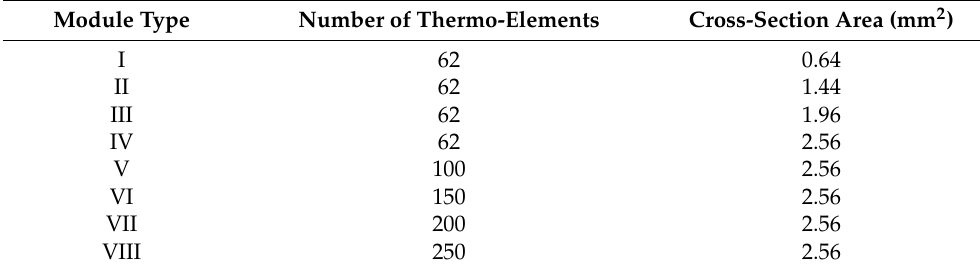
Table 2. Geometric parameters of the experimental TE modules.